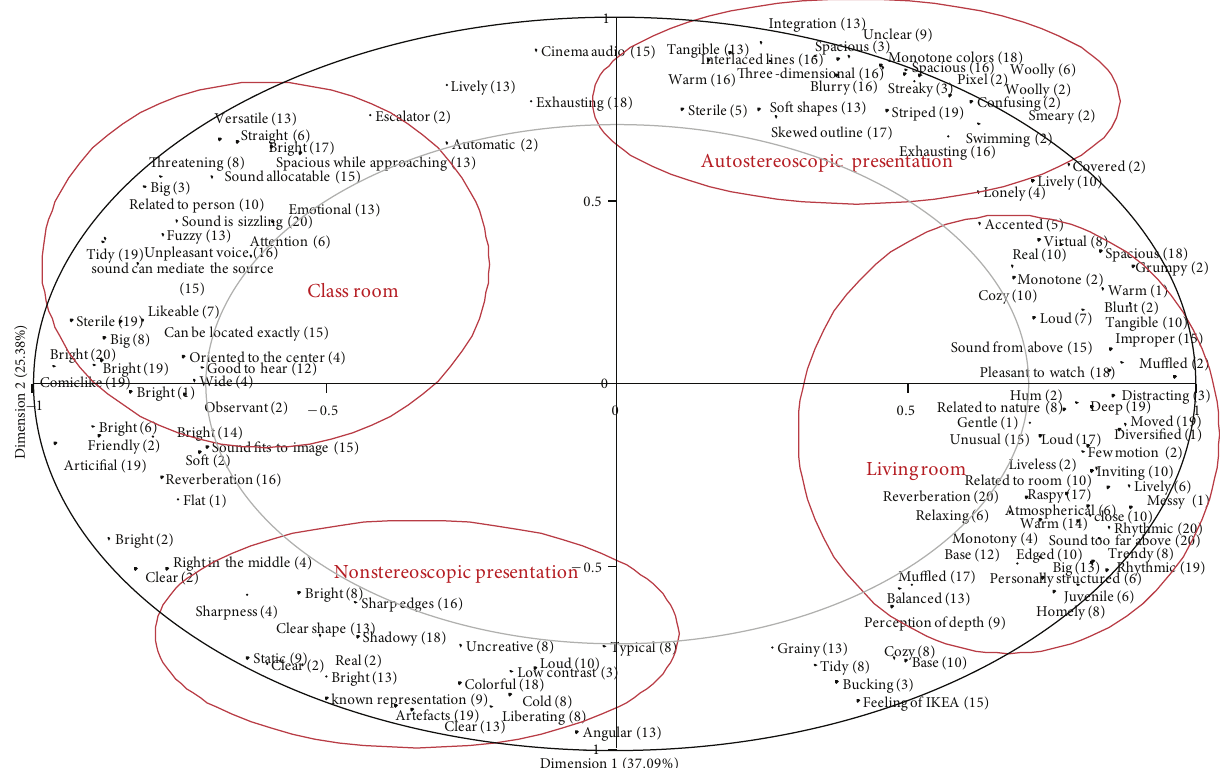
Figure 6: PCA correlation loadings with attributes in the space of PC1 and PC2.